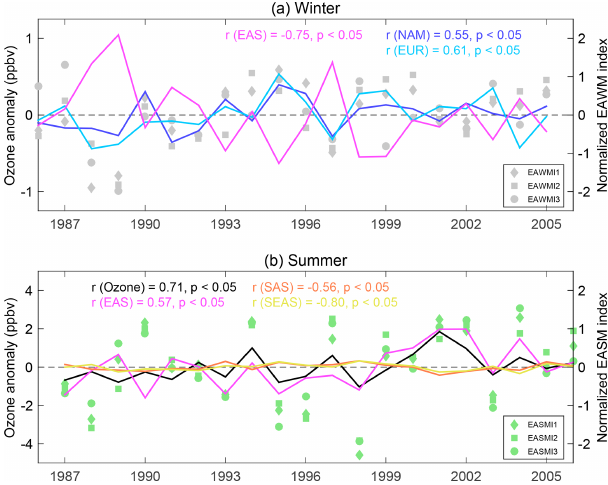
Figure 12. Interannual variations in the anomalies of foreign ozone (in ppbv, left y axis) from various regions at the East Asian sur- face driven by meteorology (Tagged-Ozone) in winter (a) and sum- mer (b) . The values are averaged over 22–46 ◦ N, 110–145 ◦ E in winter and , 22–46 ◦ N, 95–130 ◦ E in summer, where the correla- tions are the most significant. The correlation coefficients calculated with the three sets of monsoon indices in each season are averaged. The abbreviations are for East Asia (EAS), North America (NAM), Europe (EUR), South Asia (SAS), and South-east Asia